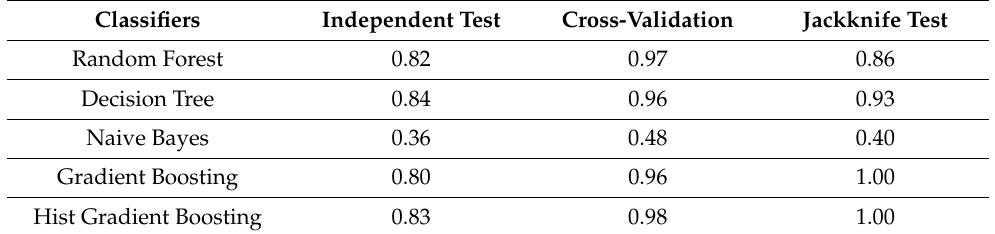
Table 7. Comparison of accuracy score for the proposed model with other ML